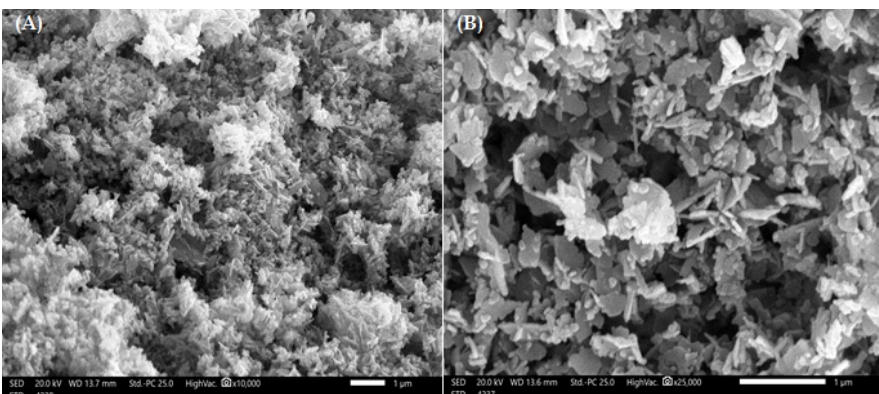
Figure 3. SEM examination at 1 µm for the prepared ZnO ‐ NP at magnifications of 10,000× ( A ) and 25,000× ( B ).